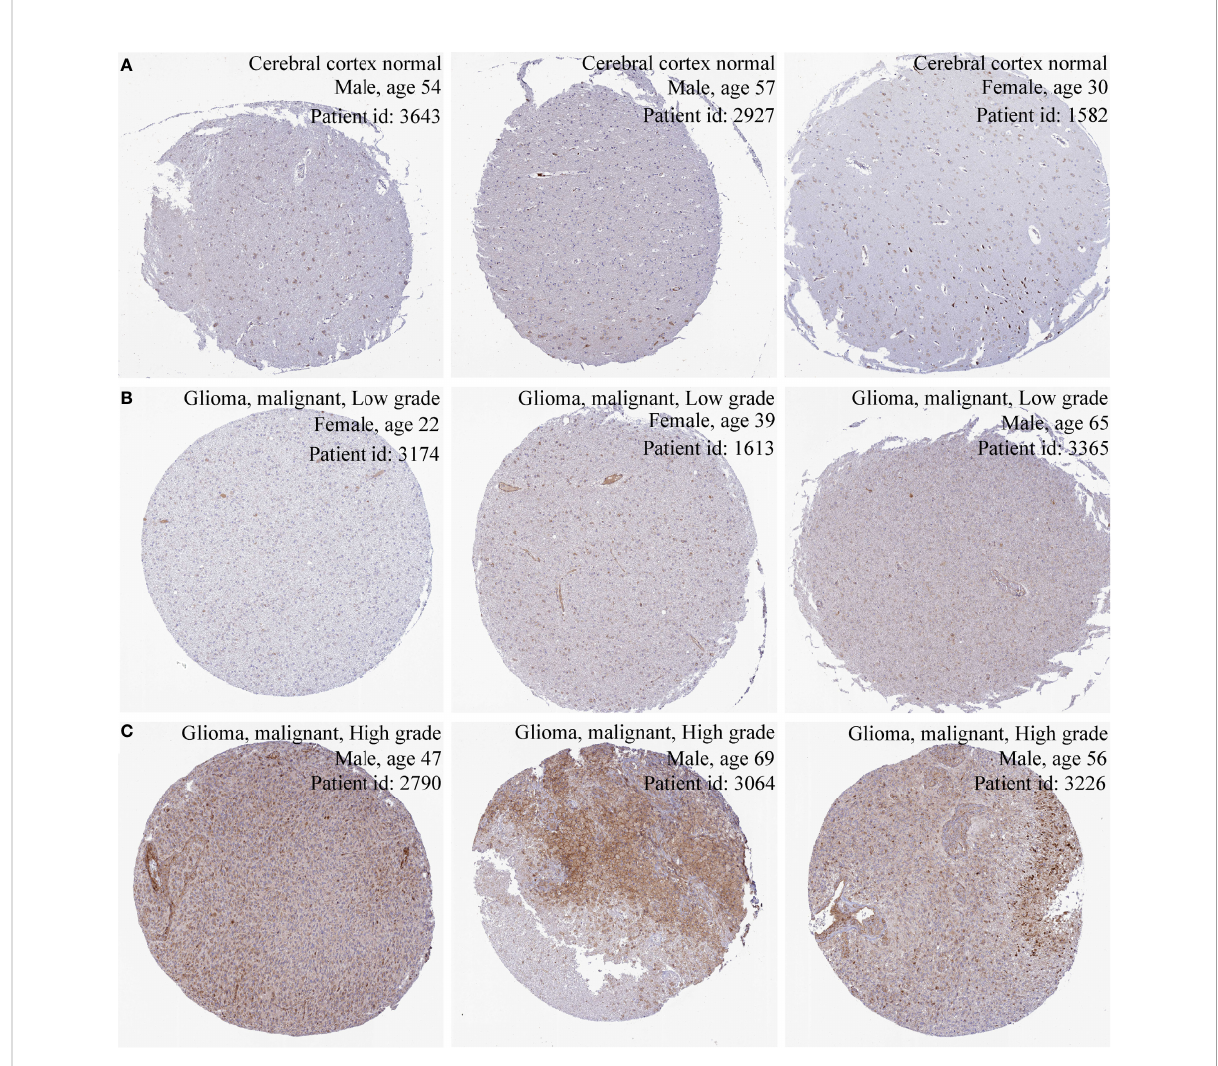
(Figure 4B). LGG patients with high PIMREG expression had worse DFS than those with low PIMREG expression ( P =